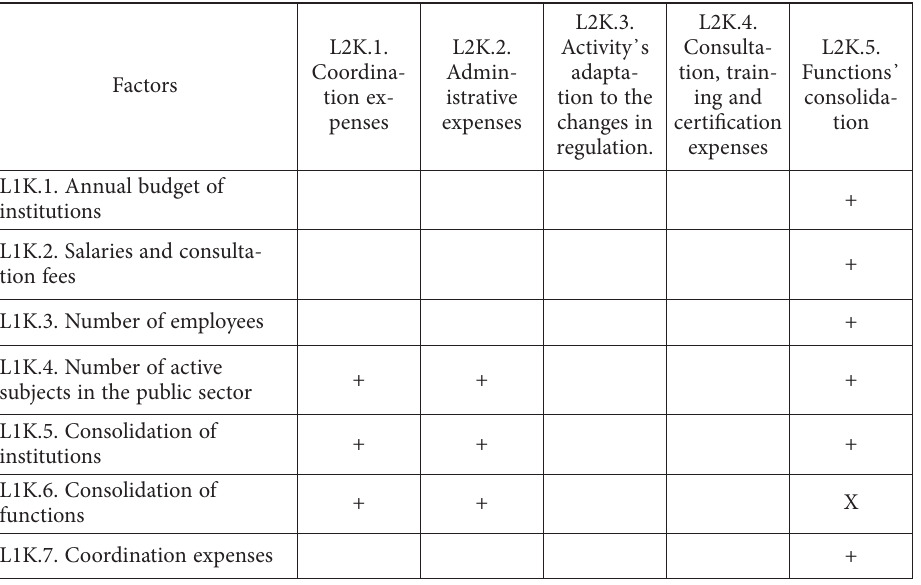
Table 2. Expenses process factors (created by the